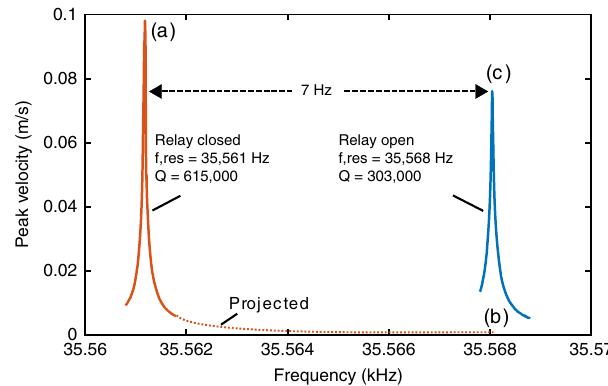
Fig. 4 Measured peak crystal velocity at two values of external capacitance (the modulation relay open or closed). The passive bandwidth of each individual curve is <0.1 Hz. Without direct antenna modulation, one would operate between points “ a ” and “ b ” on the red curve 1. Direct antenna modulation allows operation across both curves, at the points of highest fi eld, “ a ” and “ c. ”